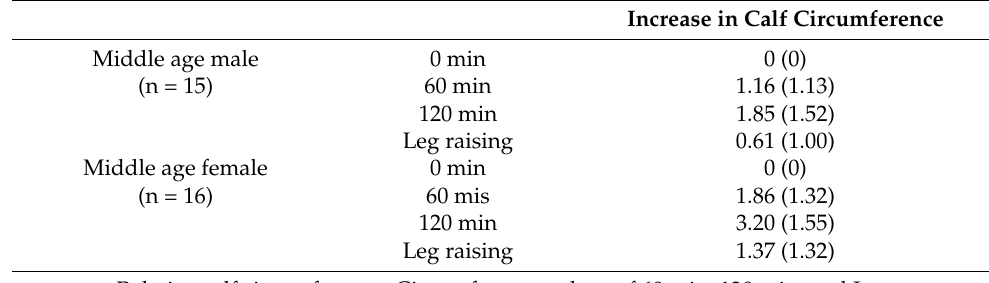
Figure 8. Change in calf circumference over time. Table 3. Change of leg circumference over time. Relative calf circumference: Circumference values of 60 min, 120 min, and Leg raising are divided by a circumference value of 0 min.